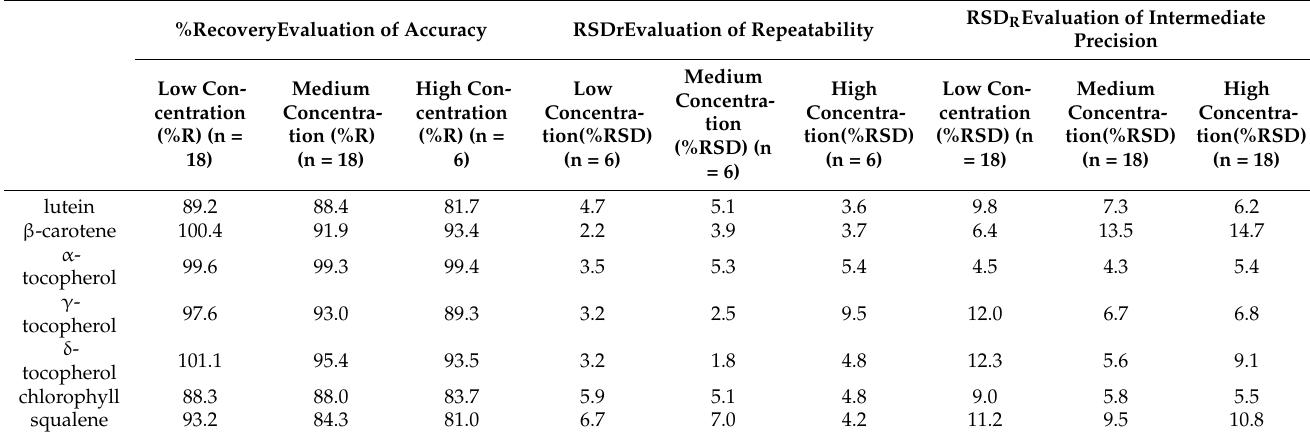
Table 4. %Recoveries and RSD for the analytes of interest.